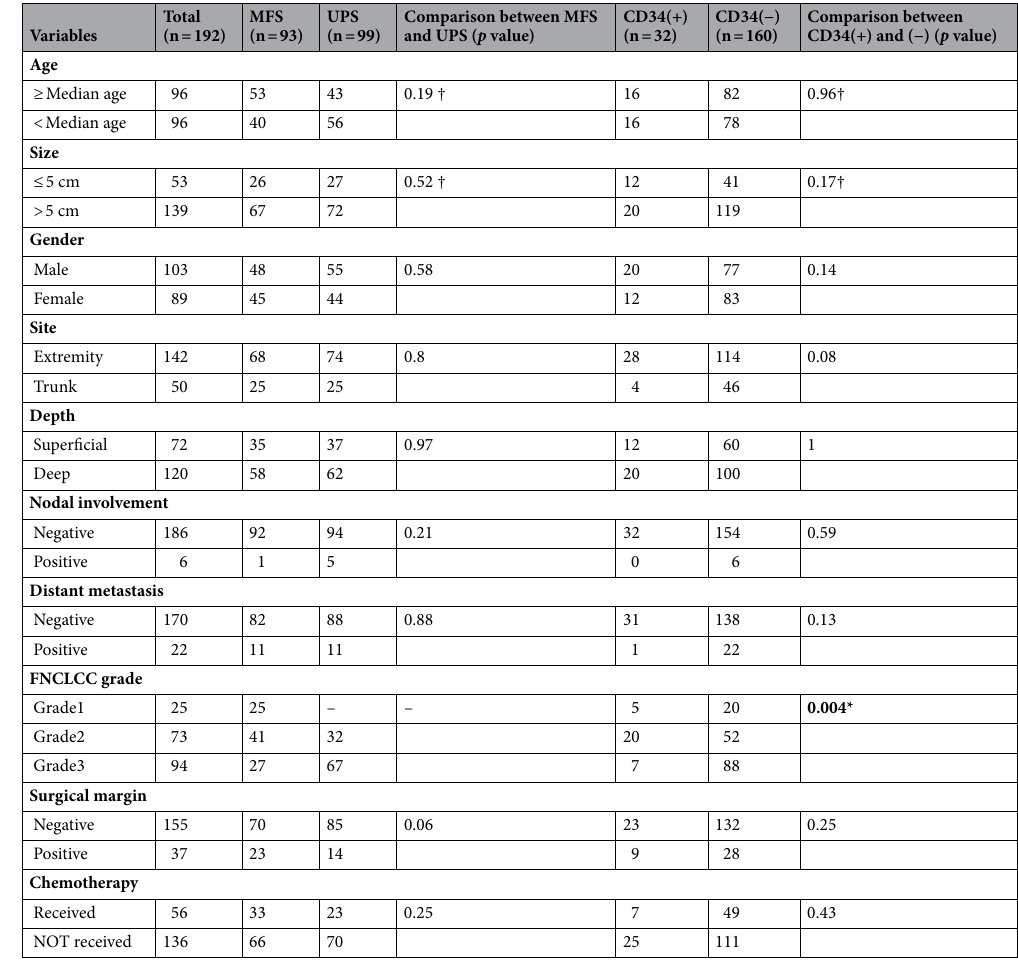
Table 1. Patient characteristics. Bold values indicate p < 0.05 * p < 0.05. For age and size, Mann–Whitney test was performed (†). For other factors, chi-square test was performed.